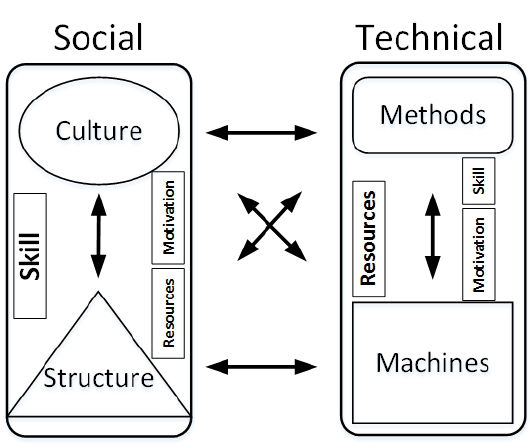
Figure 2. Attributes “produced” by the STS